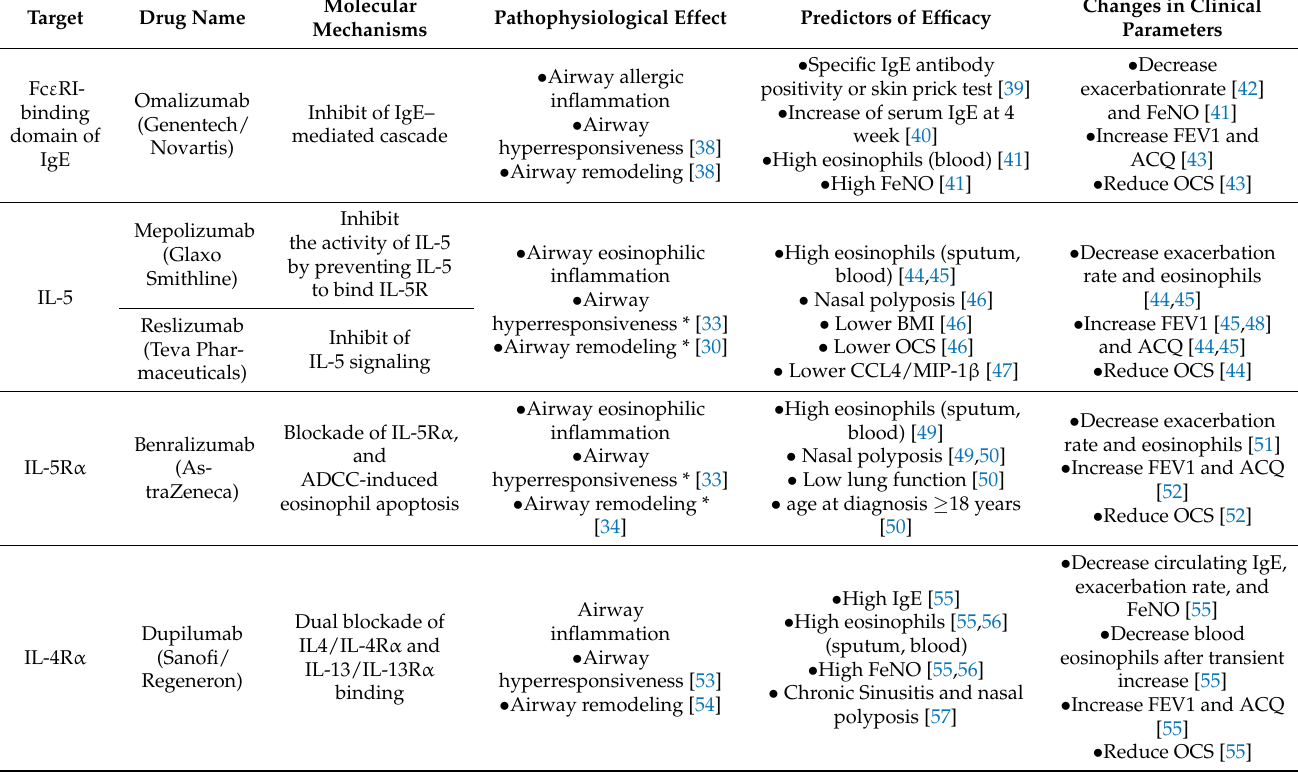
Table 1. Current strategies of biological therapies for severe